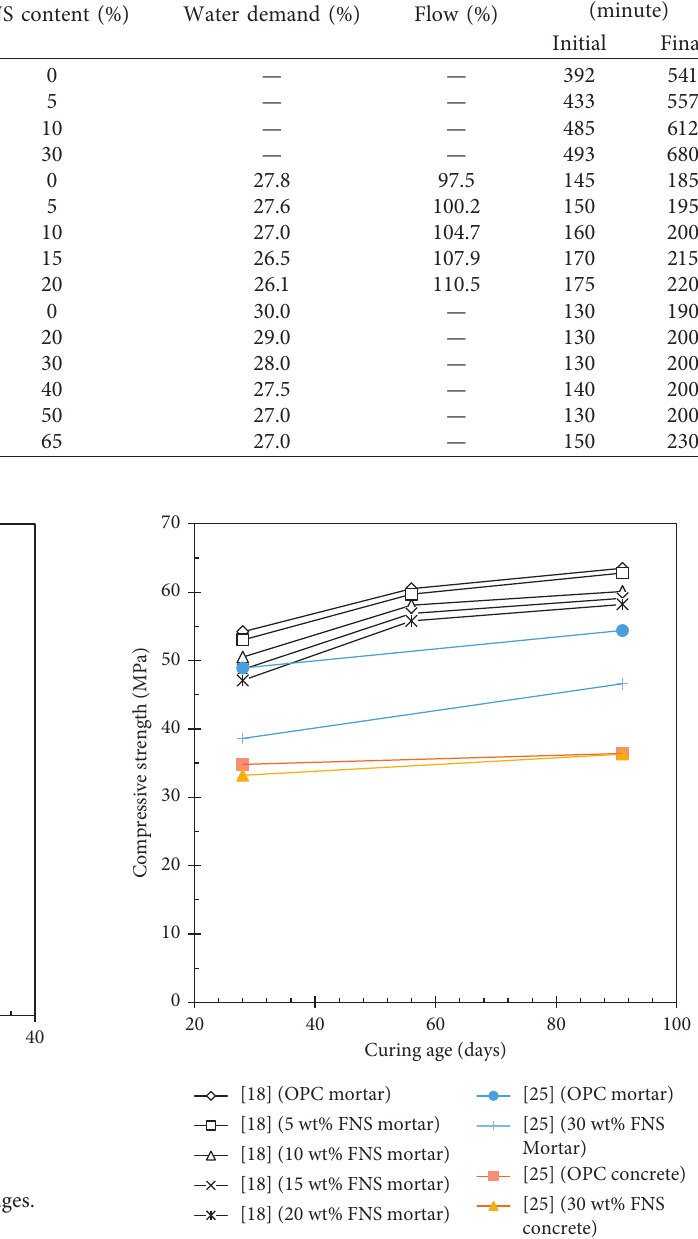
Figure 4: Compressive strength at different